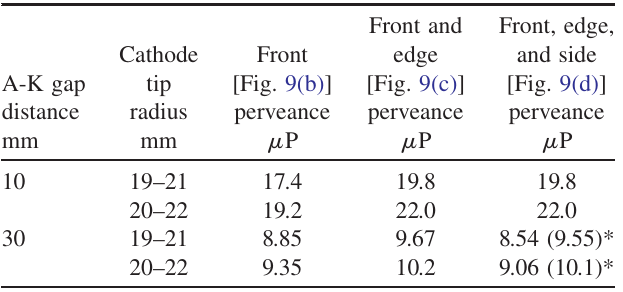
TABLE II. Comparison of perveances predicted by MAGIC2D simulation at an A-K gap voltage of 500 kV. The values with superscript * denote the perveances at 600